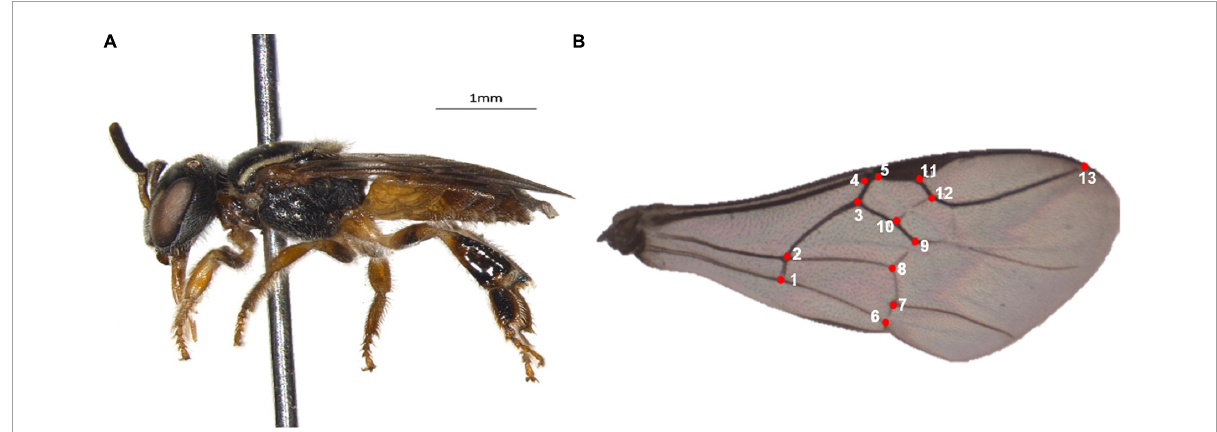
FIGURE2 Plebeia flavocincta (A) and its wing (B) showing the 13 anatomical landmarks used (Photos: UMM).